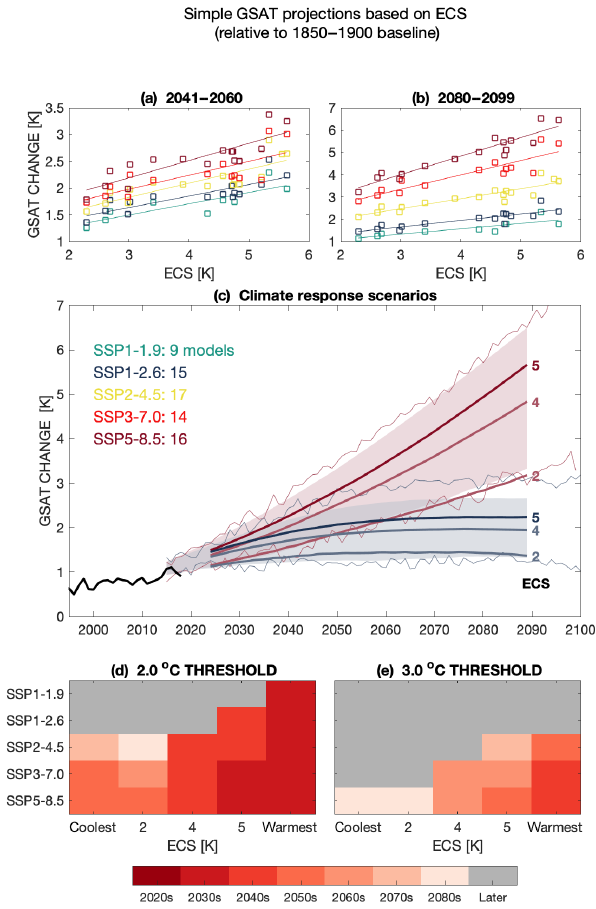
Figure 1. Scenarios for global mean surface air tempera- ture (GSAT) derived from CMIP6 projections. Panels (a, b) show regressions, for each SSP, of simulated mean GSAT for a range of models onto each model’s own estimated ECS value, for two example 20-year periods. Where multiple ensemble members are available, we have used the ensemble mean response. The simu- lations are first referenced to the mean of 1995–2014 and base- lined to an approximate pre-industrial level using an observed change from 1850–1900 to 1995–2014 of 0.76 ◦ C using Had- CRUT4 (Morice et al., 2012). Panel (c) shows three climate re- sponse scenarios (thick lines) assuming ECS values of 2, 4 and 5 ◦ C, for two SSPs (SSP5-8.5, red, and SSP1-2.6, blue), along with the 5%–95% simulated range (shaded) and the simulations with the largest and smallest responses at the end of the century (thin lines). Panels (d, e) show the decade in which 2 and 3 ◦ C GSAT thresh- olds are first crossed as a function of climate response scenario and emissions scenario. Grey shading indicates that the threshold is not crossed by 2090 (i.e. the 20-year average of 2081–2100). Note that (1) the SSPs considered are not equally spaced in terms of estimated radiative forcing; (2) GSAT declines in the latter part of the cen- tury for some SSPs and, in some cases, may fall back below one of the thresholds shown, but we do not include that possibility in pan- els (d, e) ; and (3) a different reference period choice would produce different ranges (Hawkins and Sutton, 2016), especially for the near term; we do not consider this sensitivity here and do not analyse a threshold crossing of 1.5 ◦ C for this